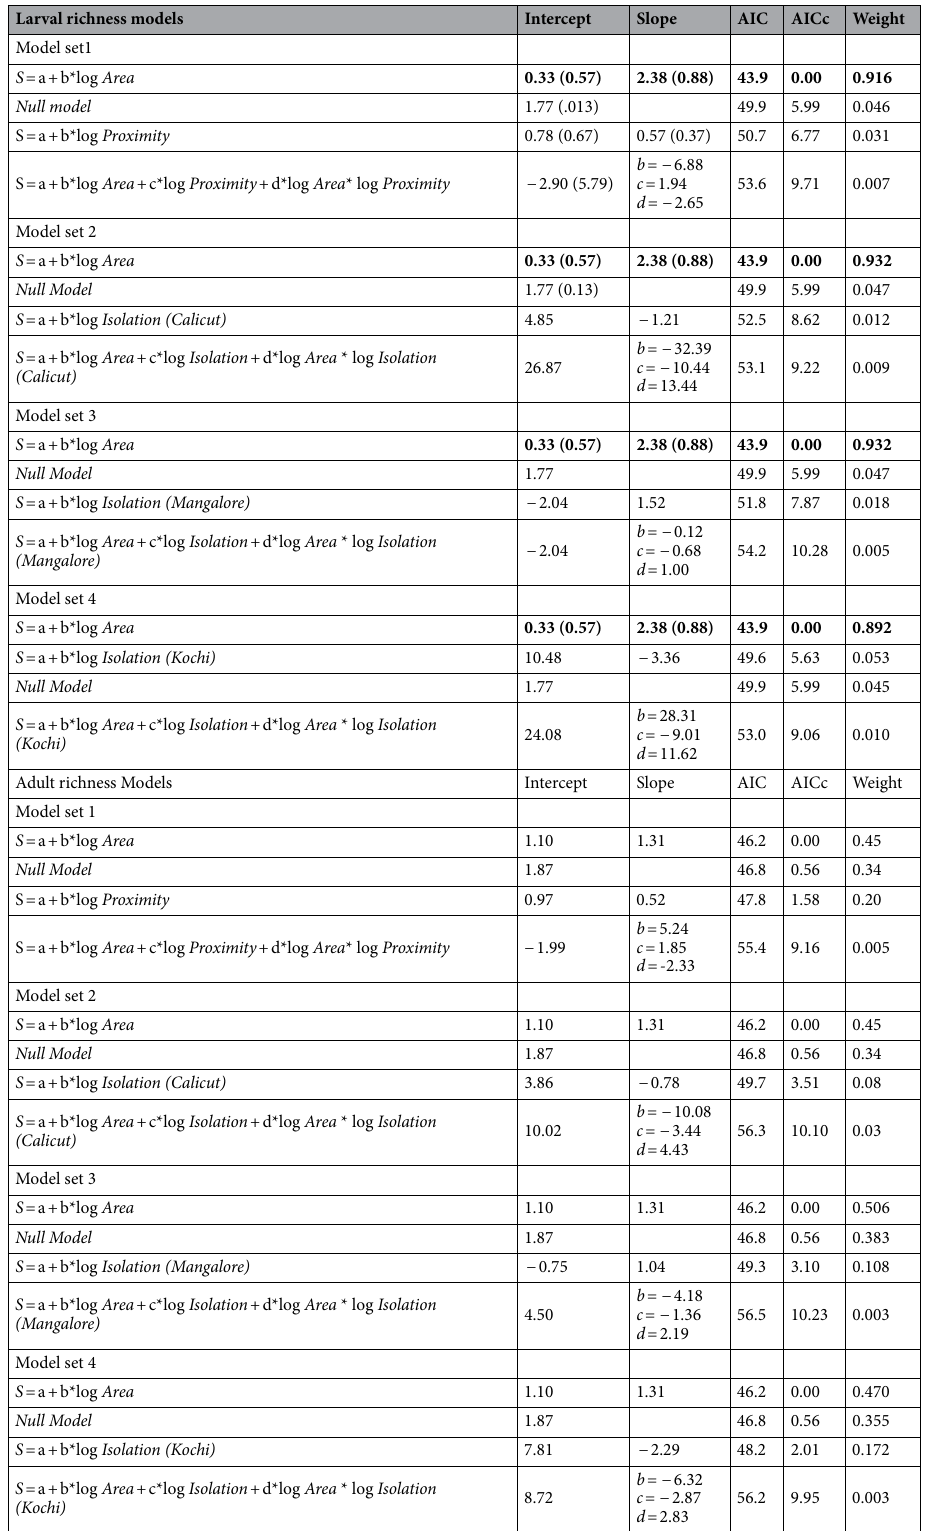
Table 1. Candidate models for predicting mosquito species richness in the Lakshadweep